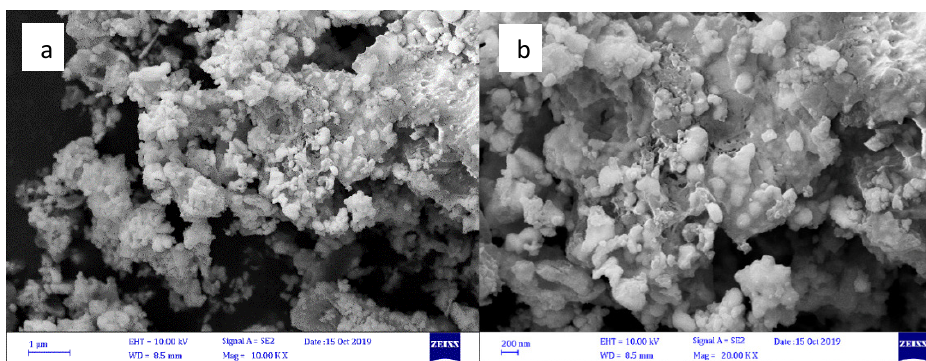
Fig. 5. SEM image of Sm 2 O 3 NPs